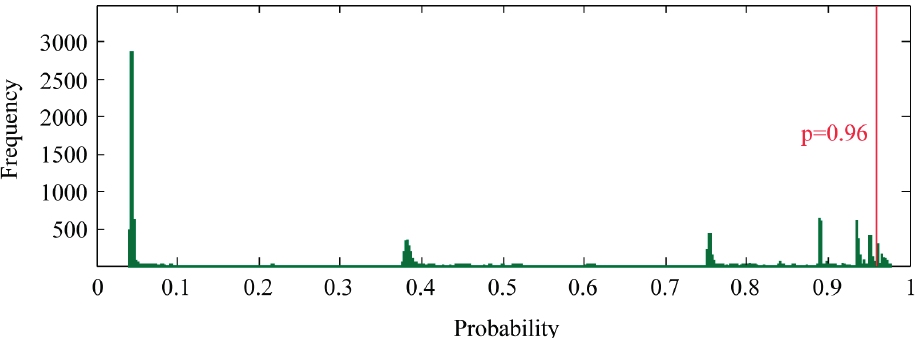
Figure 3. Genome-wide prediction of PR-interacting proteins. SVM classification probability, which measures the confidence of the prediction, was shown as frequency histogram. Bin width of 0.1% was used. PR-interacting proteins were selected using a probability threshold of